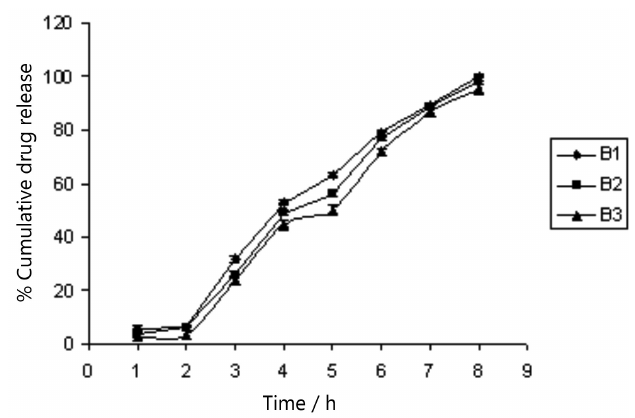
FIGURE 6 - Comparative results of in vitro release profile of hydroxypropyl methylcellulose (HPMC) with sodium alginate (SA)-based diclofenac beads.